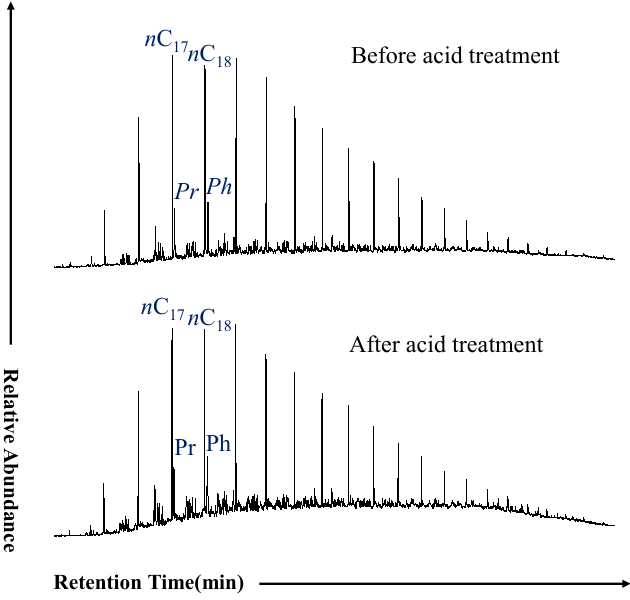
Figure 7. Whole oil chromatogram of wellhead blockage in Well DH231 before and after acidification (RIC).